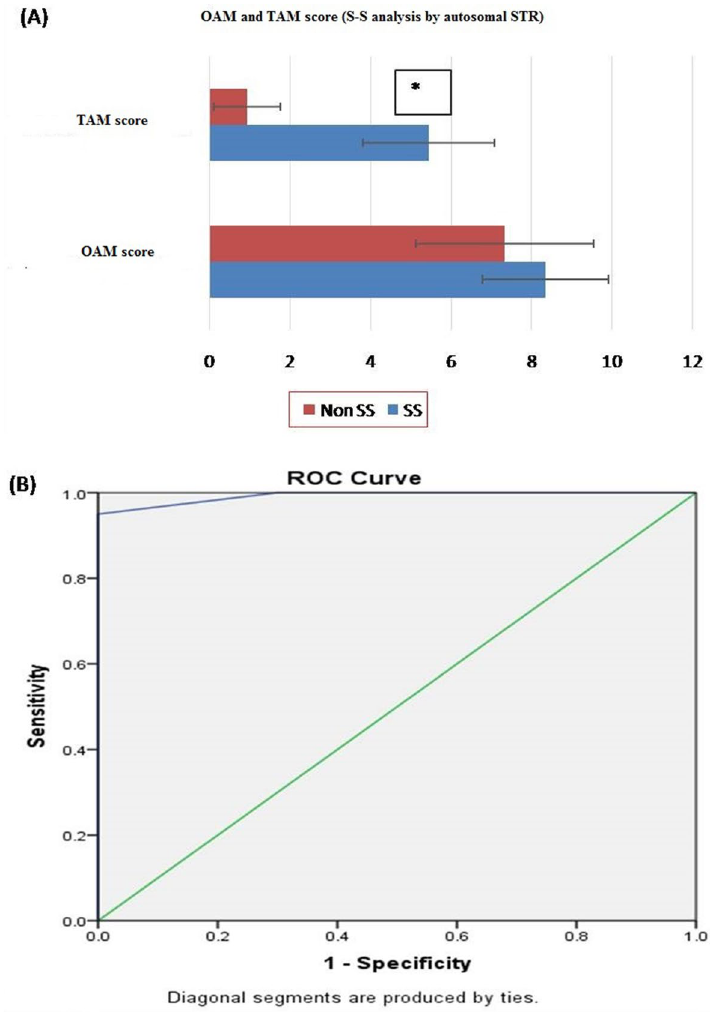
Figure 5. ( A ) TAM score for S–S analysis by autosomal STR. Based on the TAM score, statistically significant difference between S–S (related) and non-S–S (unrelated) groups was seen with autosomal STR. The Average TAM score for S–S is 5.45 ± 1.63 (SD), whereas, for the non-S–S group, the average TAM is 0.95 ± 0.326 (SD). Figure 5 (A & B) obtained from SPSSsoftware version 22.0 (Available for download at: https:// www. ibm.